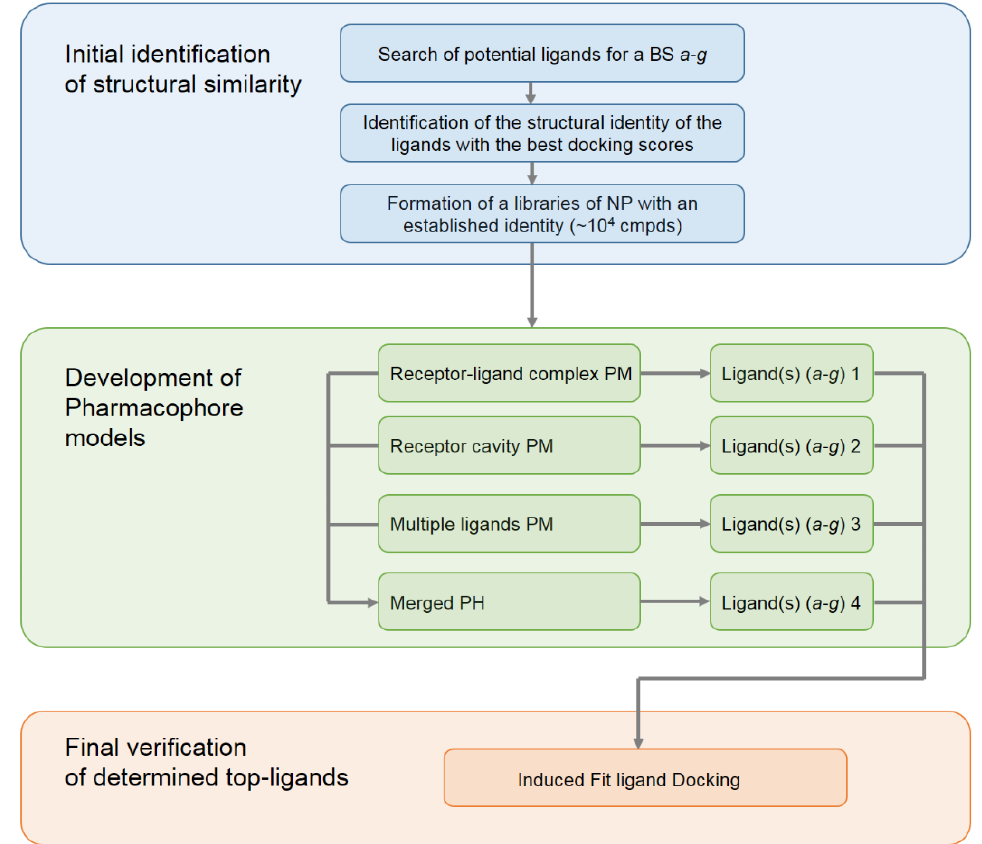
Figure 2. The general scheme of the workflow for the development of pharmacophore models used for the search of new inhibitors (carried out and applied in the present study).